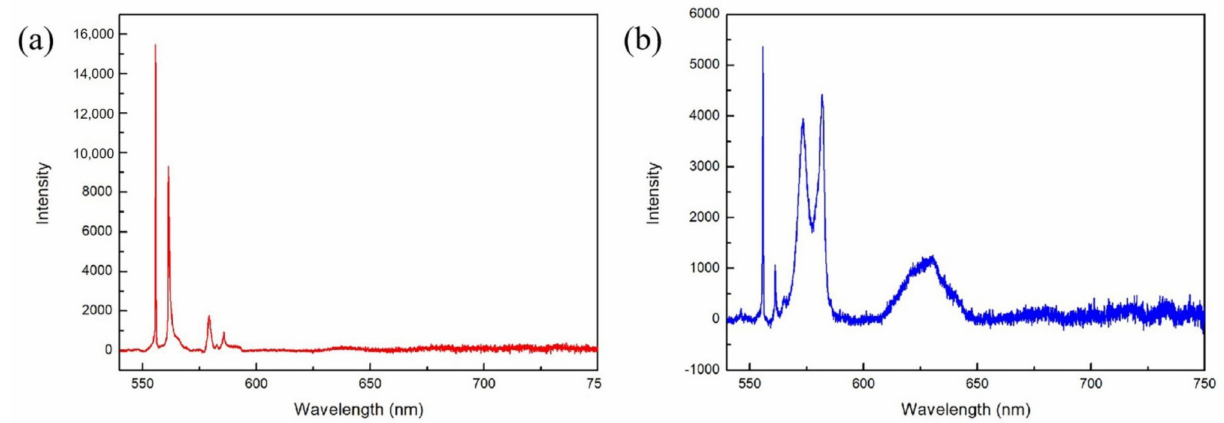
Figure 5. PL signals for different SiC films. ( a ) Normal SiC film. ( b ) Multi-layer SiC